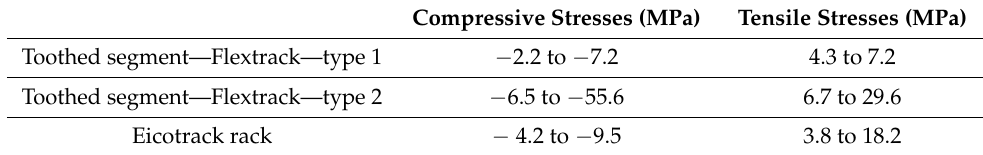
Table 1. Scope of measured stress values in Flextrack and Eicotrack haulage system elements.